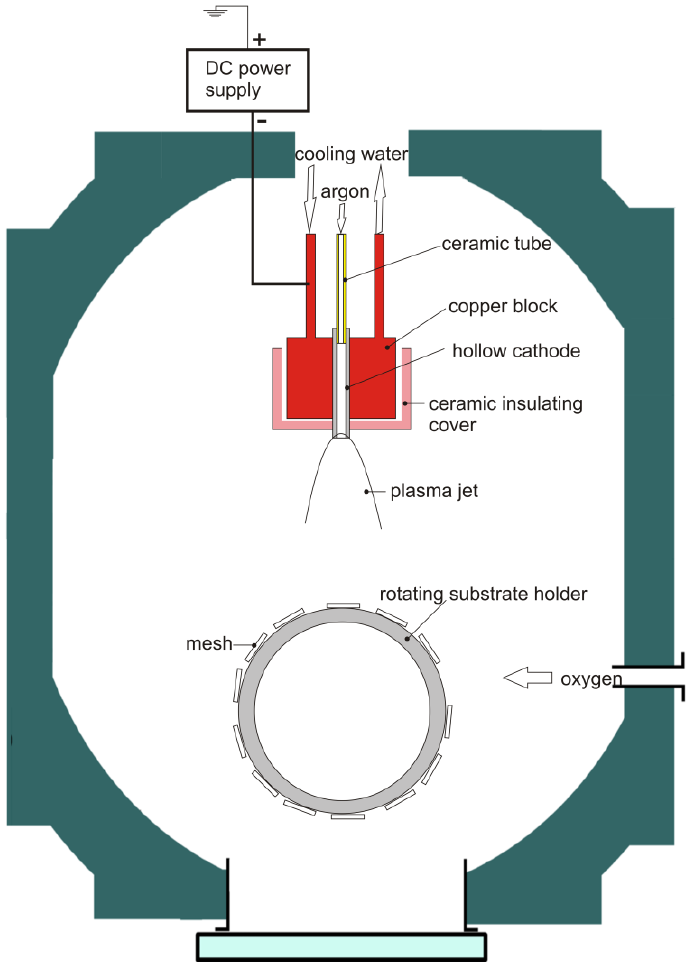
Figure 10. Scheme of the hollow cathode sputtering system used for the active phase deposition on the stainless steel meshes. Table 9. Experimental conditions used for the preparation of Ni-Cu oxide catalysts (substrate tem- perature < 60 °C; three layers deposited at pressure 2, 80, and 2 Pa), and the average amount of oxides deposited on a single mesh.